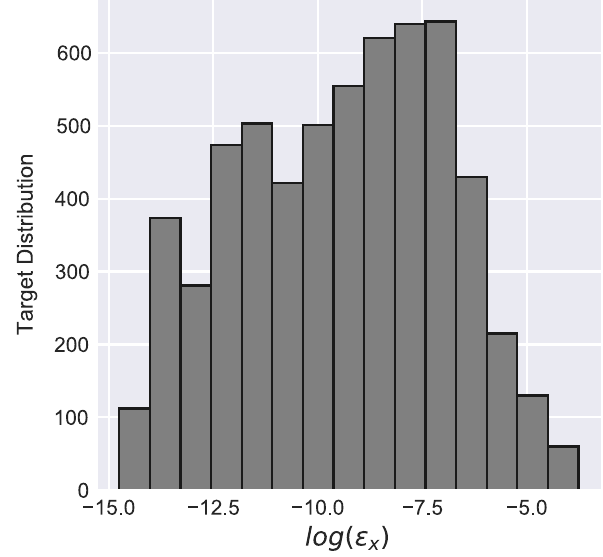
FIG. 5. Histogram outlining the distribution of log emittance in the learning dataset.